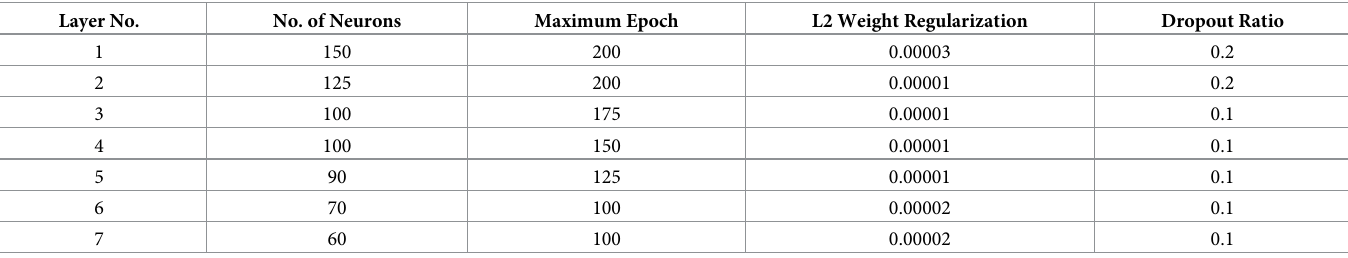
Table 3. Precise fine-tuned parameters for Offshore Windfarm 2. Layer